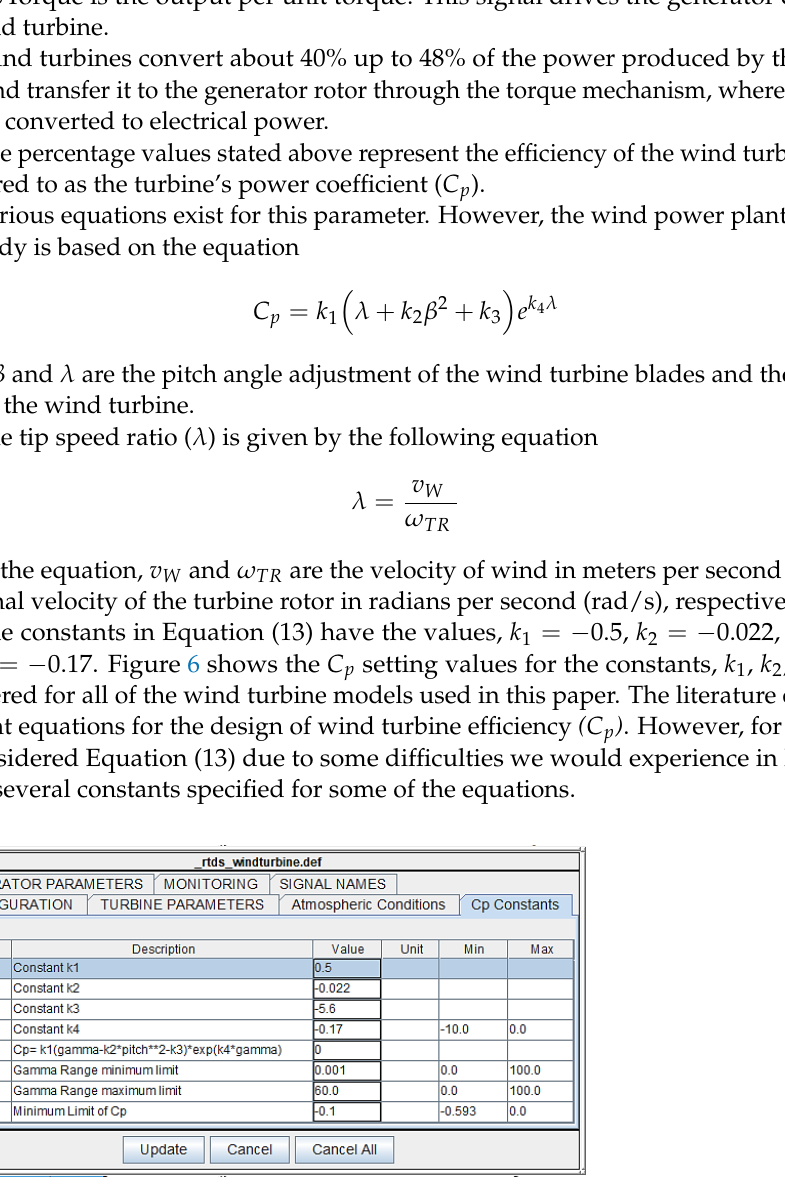
Figure 6. Power coefficient ( Cp ) parameter settings of the wind turbine. The stars ( ∗ and ∗∗ ) in the description C p = k1 ( gamma − k2 ∗ pitch ∗∗ 2 − k3 ) ∗ exp ( k4 ∗ gamma ) presents a multiplication sign ∗ and a squared (to the power 2) sign ∗∗